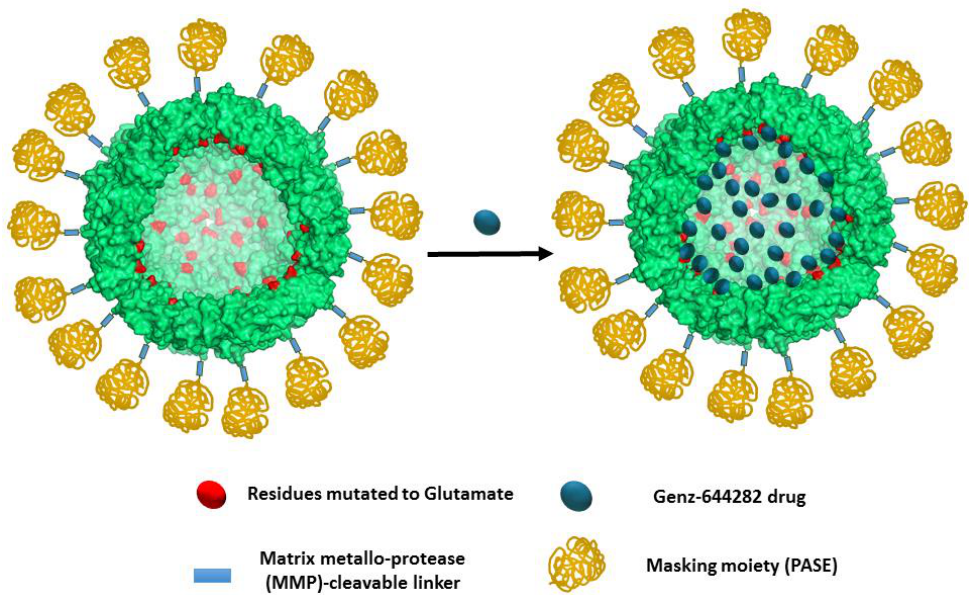
Figure 1. Schematic representation of The-0504. The Lys53, Lys71, Thr135 and Lys143 residues are mutated to Glutamate (Glu) in the The-05 protein (left). Mutated residues are colored red. Metalloprotease cleavable sequence and PASE polypeptide are colored light blue and gold, respectively. Genz-644282 drug is colored blue. All other residues are light green. To allow the internal surface of the protein to be visualized (lighter colors), only 18 monomers are shown. The picture has been generated with PyMol.